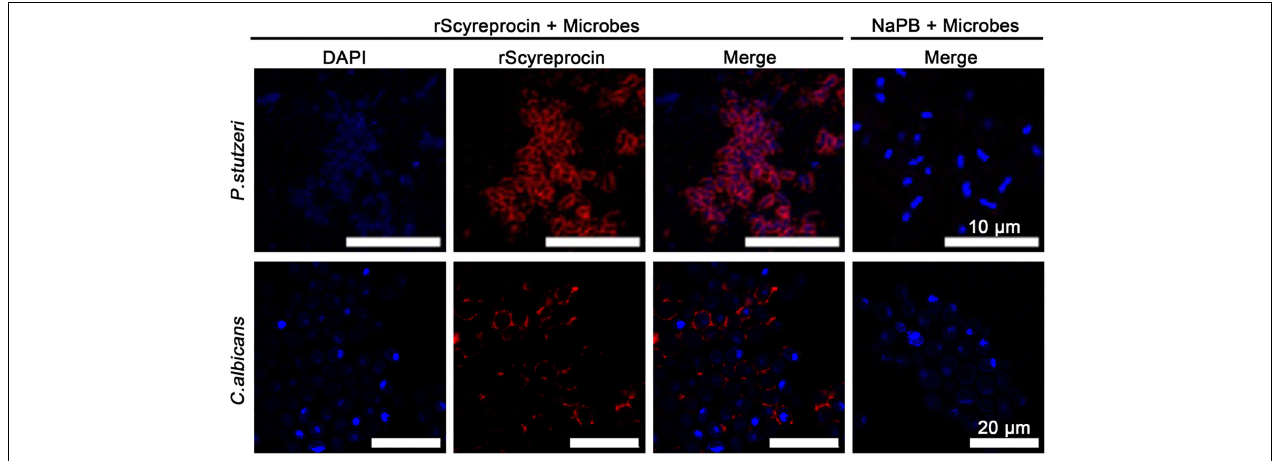
FIGURE 4 | Localization of rScyreprocin in Pseudomonas stutzeri and Candida albicans . Exponential phase microbial cells were resuspended in culture media supplemented with NaPB (control) or rScyreprocin (4 µ M) for 10 min. Samples were submitted for immunofluorescence analysis and observed by a confocal laser scanning microscopy. For the microbes treated with NaPB, only merged images are shown.